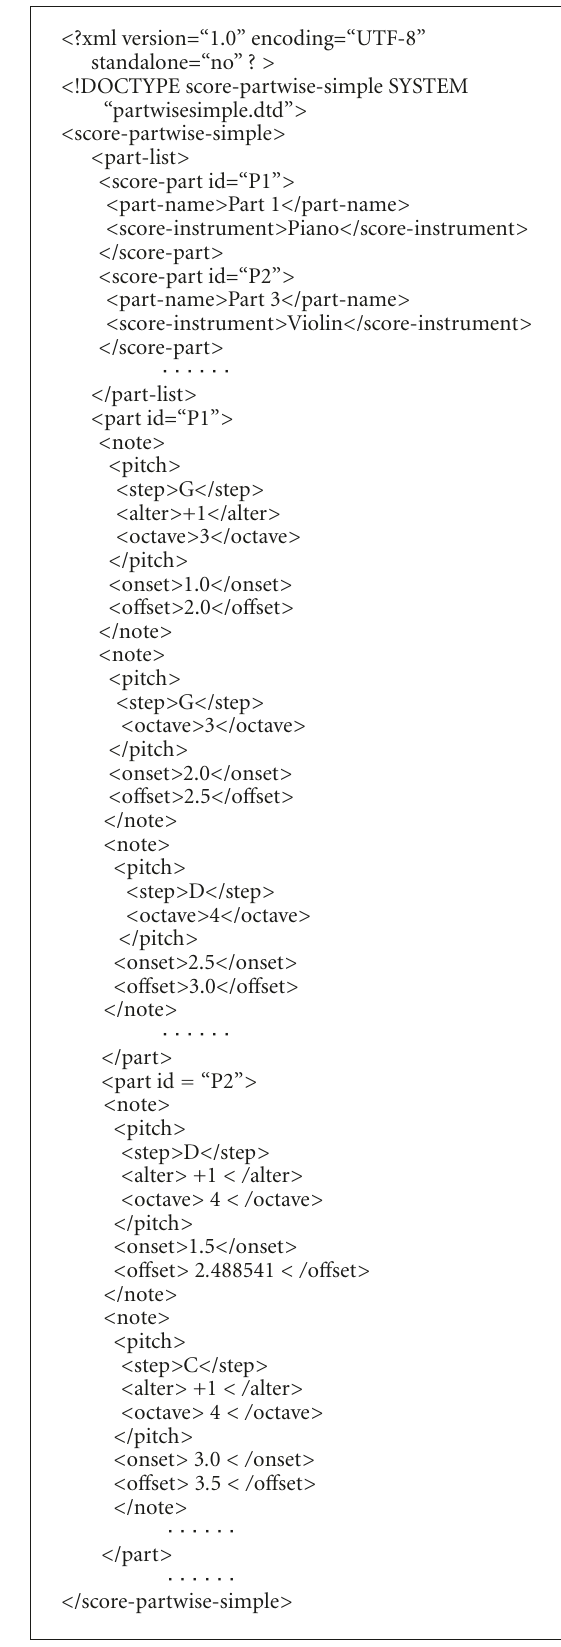
Figure 8: Example of MusicXML